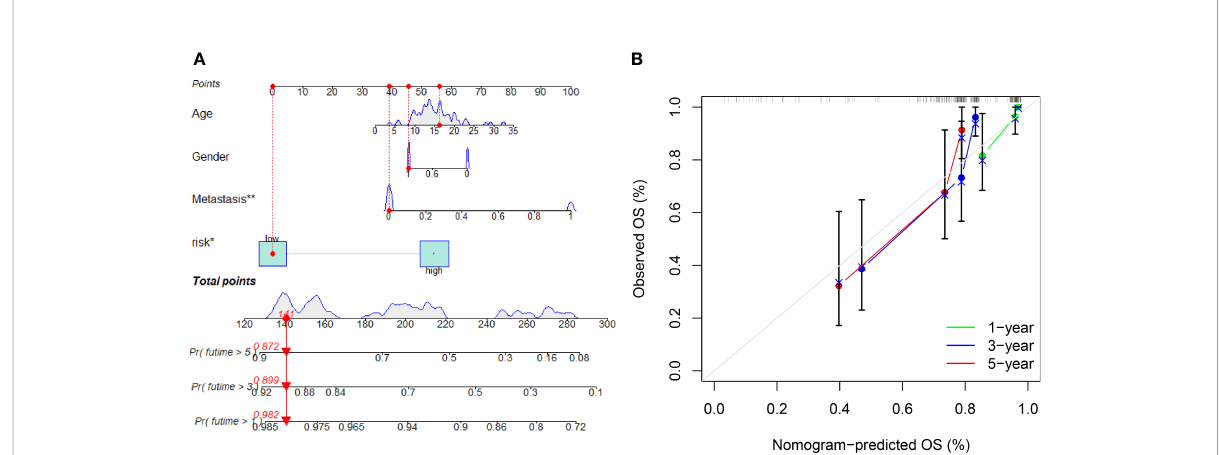
FIGURE 6 A nomogram conducted to predict the overall survival of OS patients. (A) Nomogram for estimating overall survival in OS patients. (B) The calibration plots of the nomogram. The x-axis shows expected survival, whereas the y-axis shows the actual survival. The result shows that our